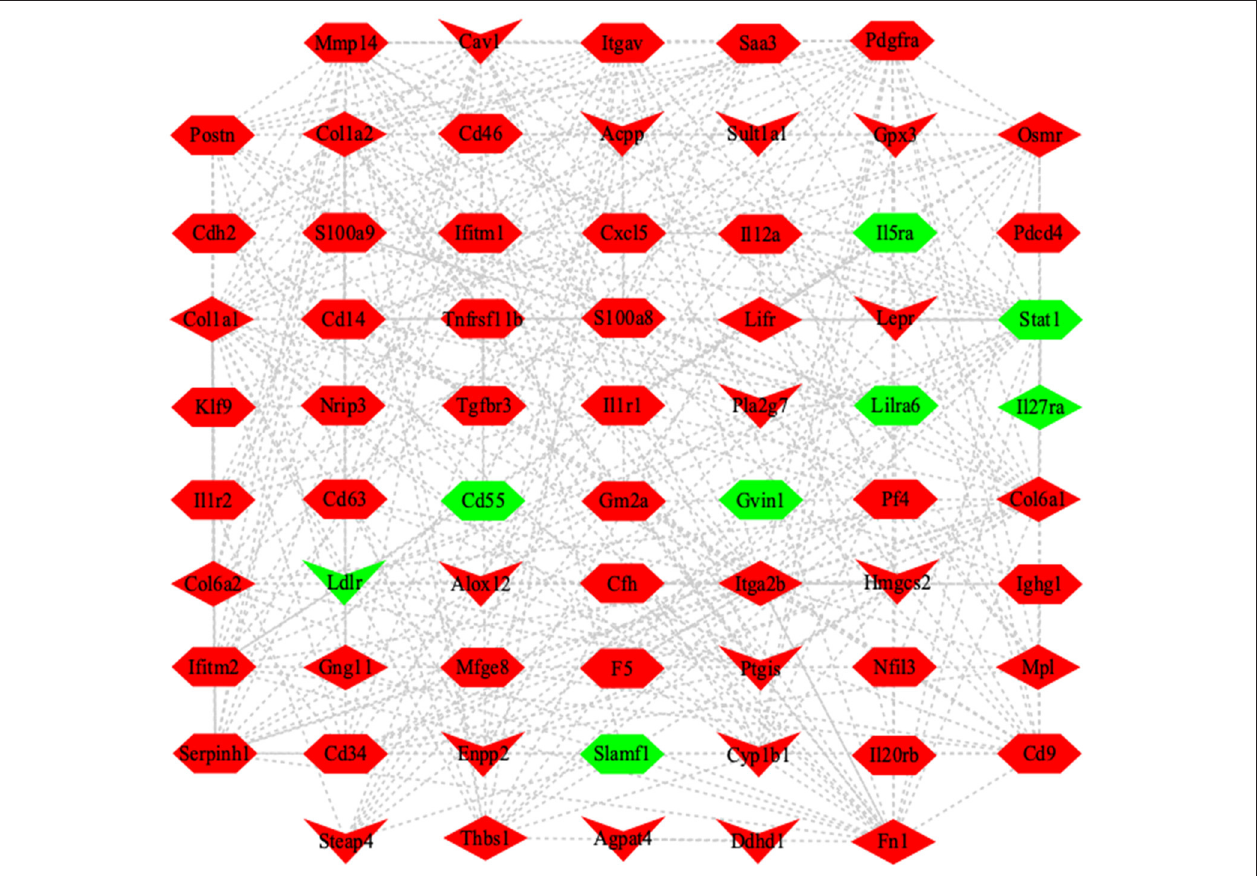
FIGURE 7 | Co-expression network of DEGs in the splenic B cells infected with the larval E. granulosus . The network was based on the mathematical relevance (Correlation > 0.99, Correlation < − 0.99, and P -value < 0.05) to search similar expression profiles of mRNAs using Cytoscape software (version 3.8.0). The hexagon represents inflammation-related genes. V represents the genes related to lipid metabolism. The diamond represents the DEGs in JAK-STAT signaling pathway and PI3K-AKT signaling pathway. Red and green indicate the upregulated and downregulated genes, respectively. The gray line represents the edge that interacts between